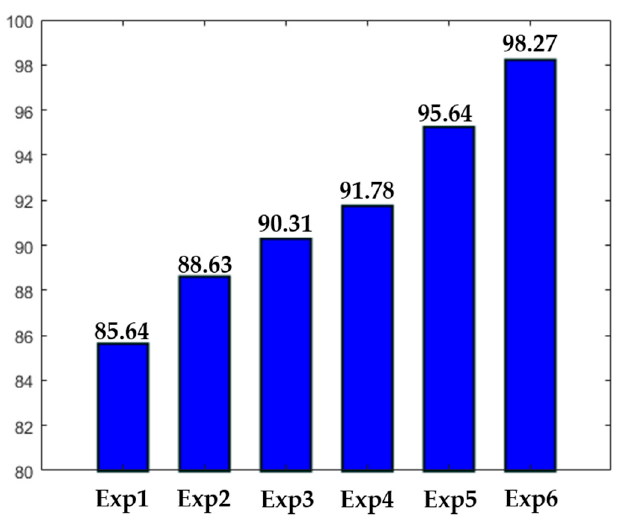
Figure 16. Results of the different hypotheses during the experiments.